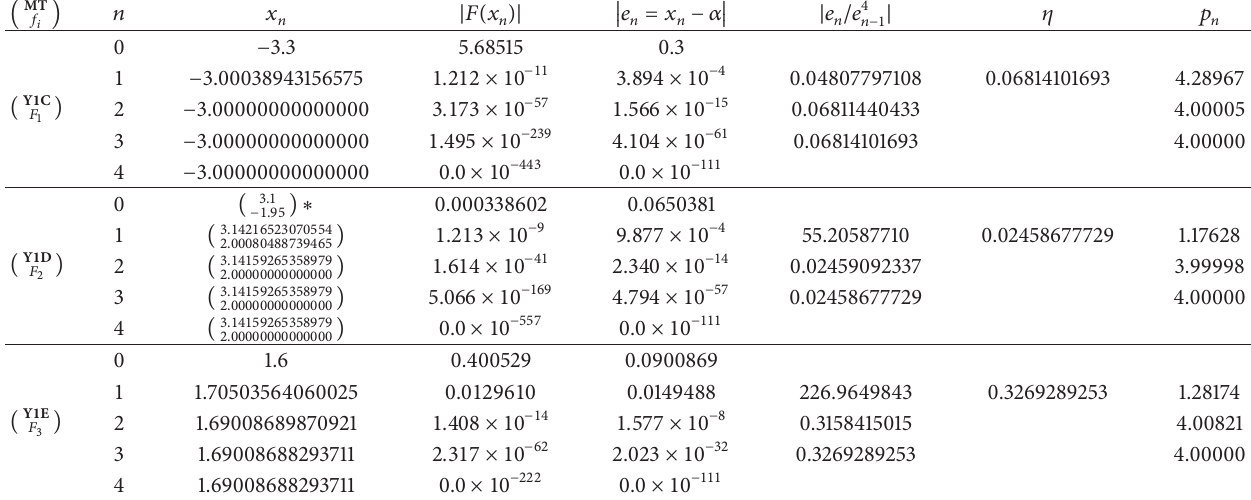
Table 3: Convergence for test functions 𝐹 1 (𝑥) − 𝐹 3 (𝑥) with methods M1F , M2E , and M2F .